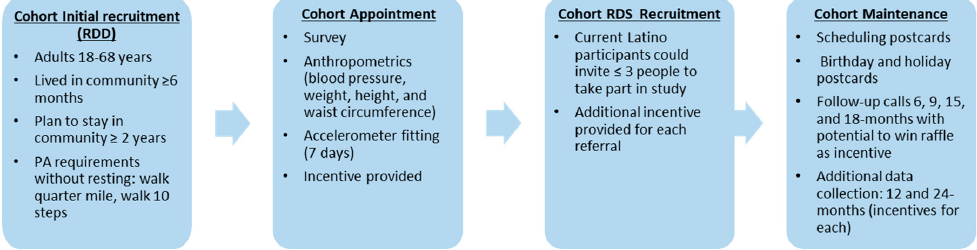
Figure 2. Longitudinal cohort recruitment, measurement, and maintenance procedures.